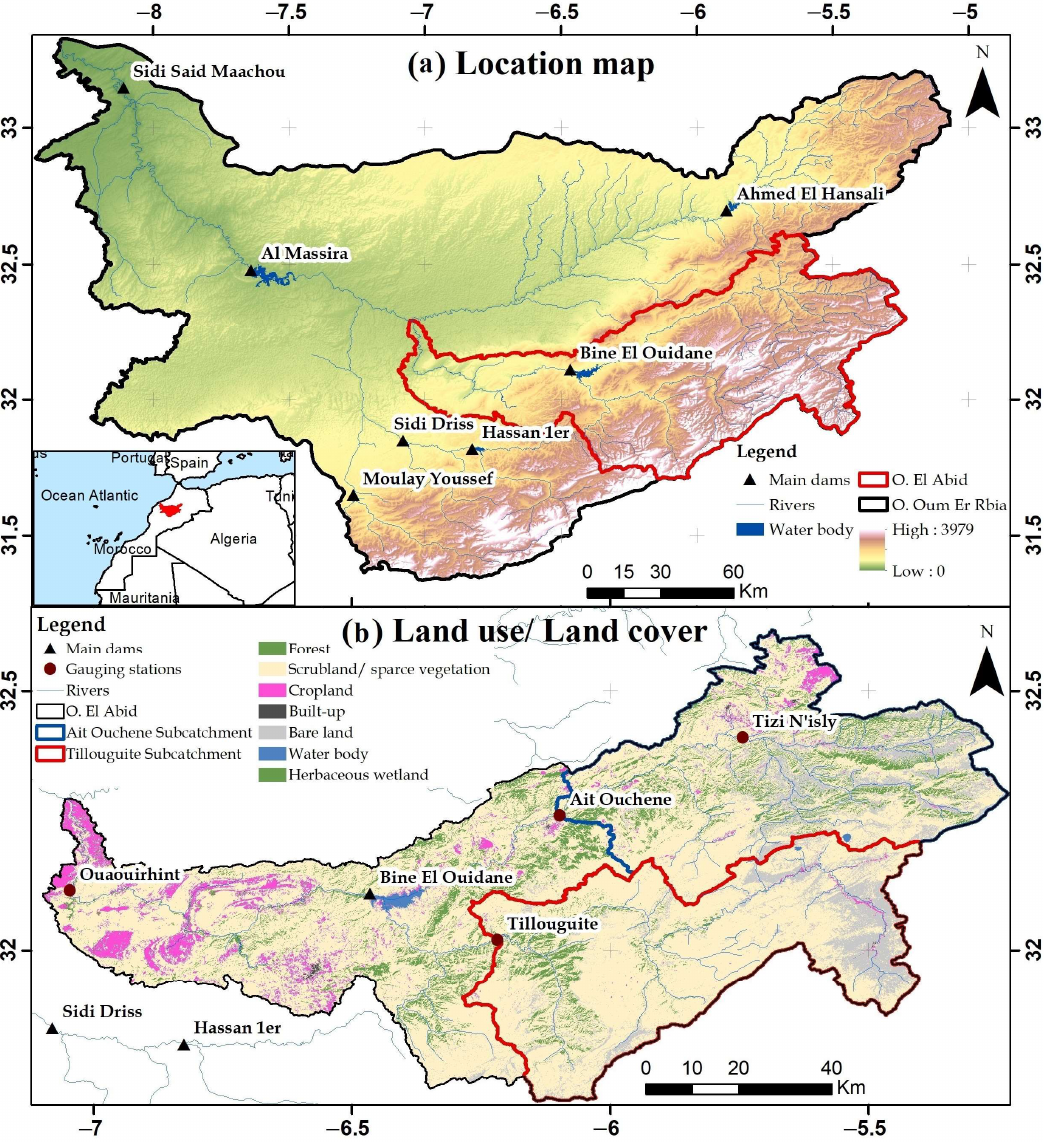
Figure 1. ( a ) Geographic situation of the Oued El Abid catchment. ( b ) Land use/land cover map. The climate of the catchment is influenced by the high diversity. According to [6], streamflow variation is strongly linked to rainfall, temperature, and snow cover